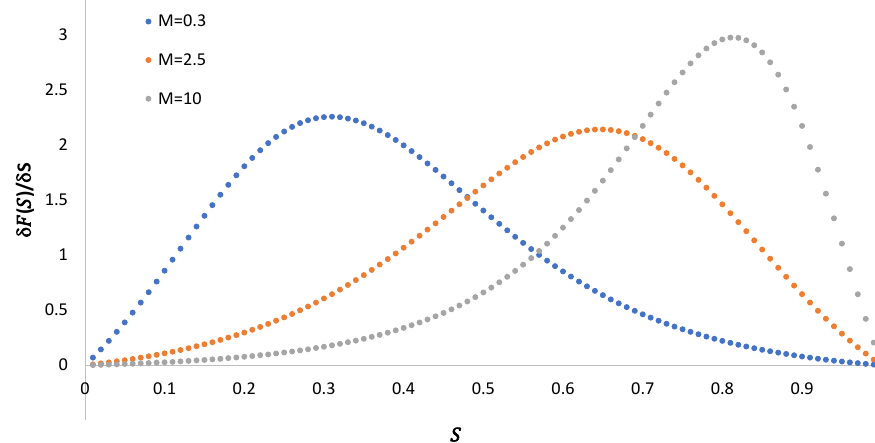
Figure 5. The derivative of F ( S ) as a function of saturation for the three mobility